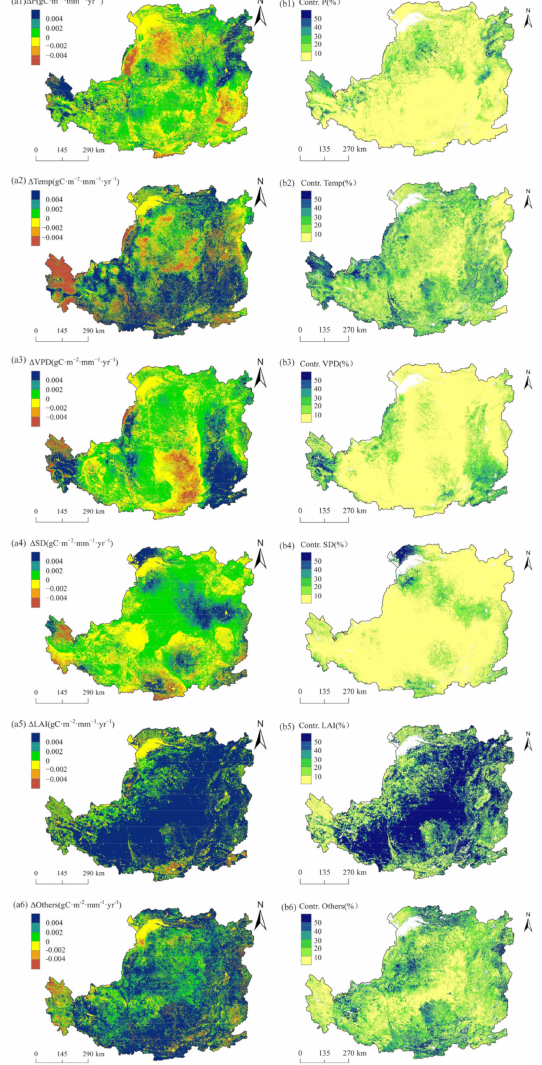
Figure 8. Spatial patterns of the ( a1 – a6 ) impacts and ( b1 – b6 ) relative impact rates of the P, Temp, VPD, SD, LAI, and other factors on the WUE trend.